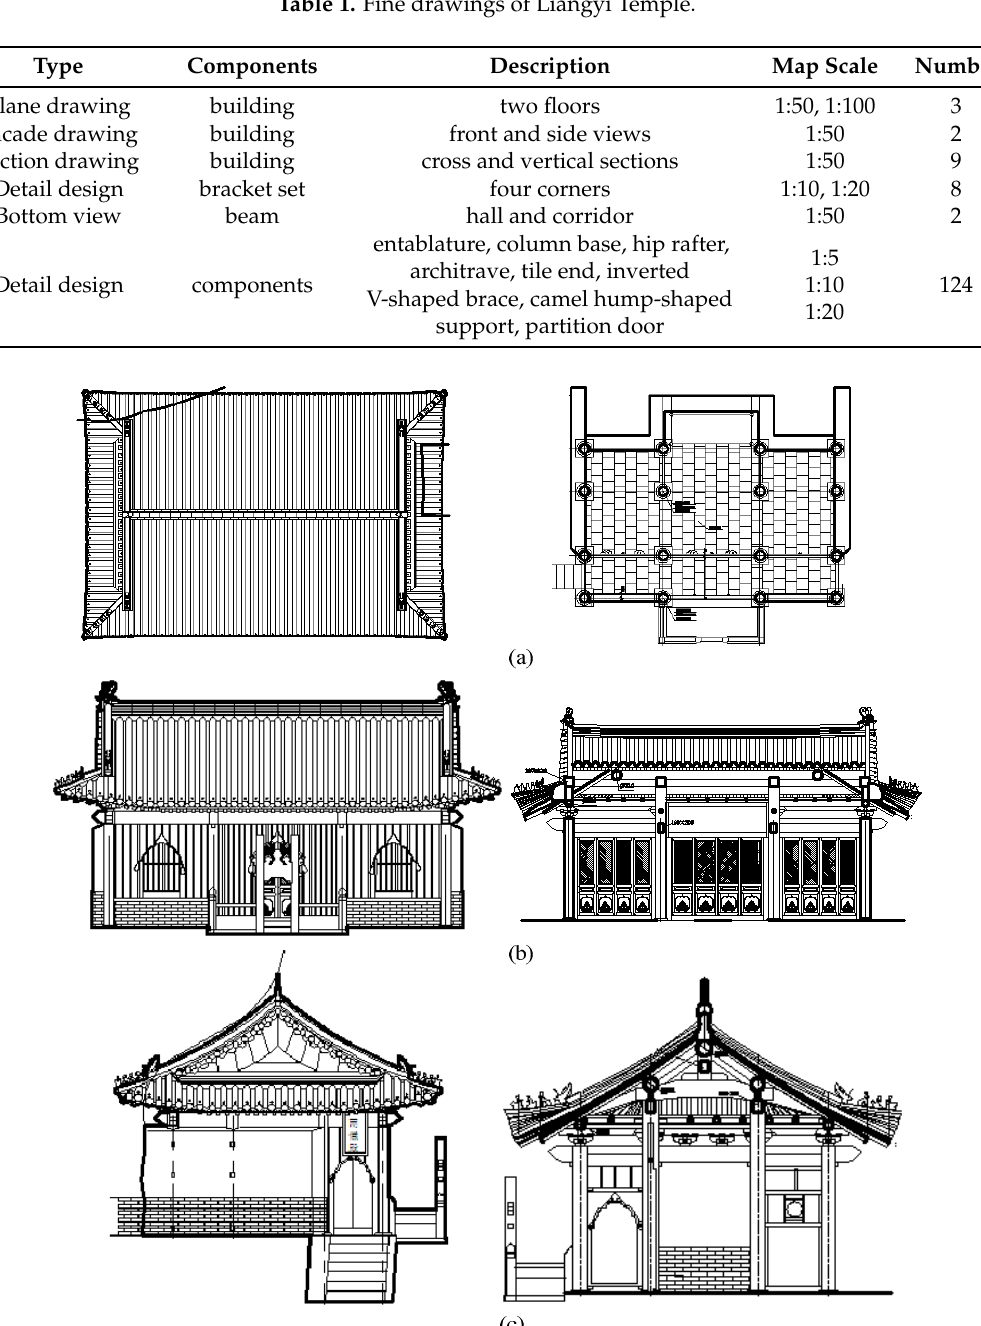
Table 1. Fine drawings of Liangyi Temple.